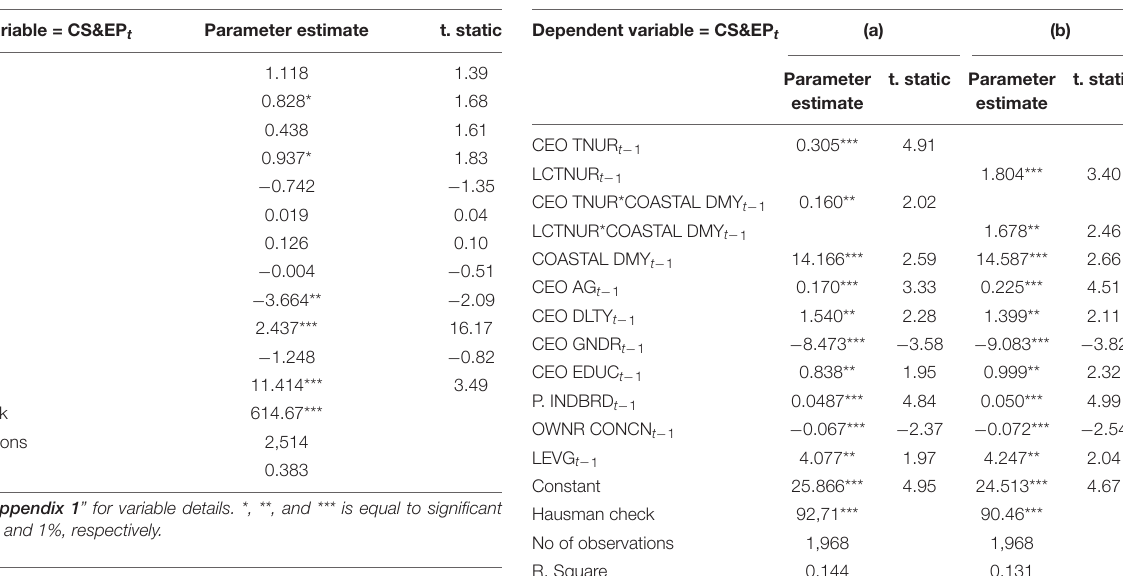
TABLE 5 | The effect of the CEO’s initial service years on CS&EP.